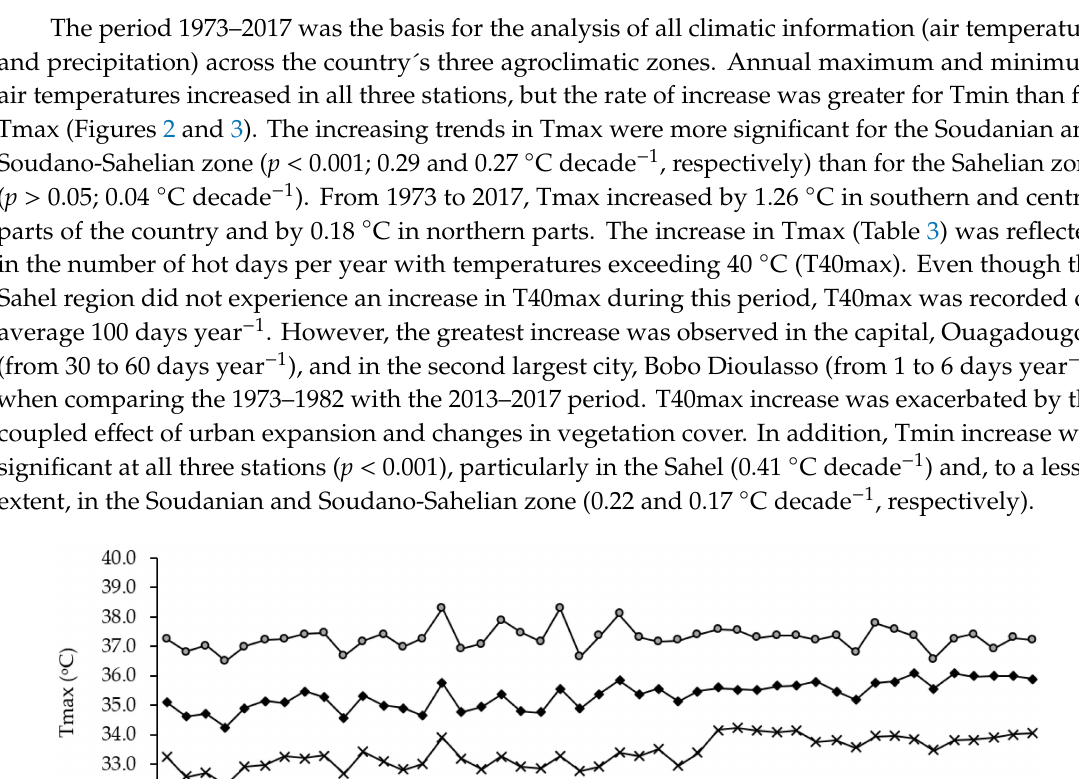
− 1.0 Figure 4. Total annual precipitation (mm), lineal regression, and statistical significance along the different agroclimatic zones (Soudanian, Soudano-Sahelian, and Sahelian) for the period 1973–2017. Table 4. Changes in annual precipitation ( µ) and interannual rainfall variability (cv) along the different agroclimatic zones (Soudanian, Soudano-Sahelian, and Sahelian) for the period 1973–2017.